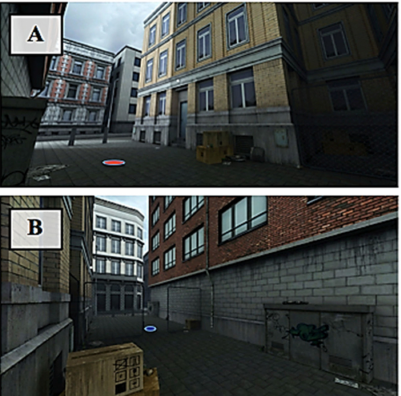
Figure 1. ( A ) Virtual environment of the participant’s side of the fence; the red spot indicates the participant’s approximate starting position; ( B ) virtual environment from the opposite angle; the blue spot indicates the approximate goal position in the proactive